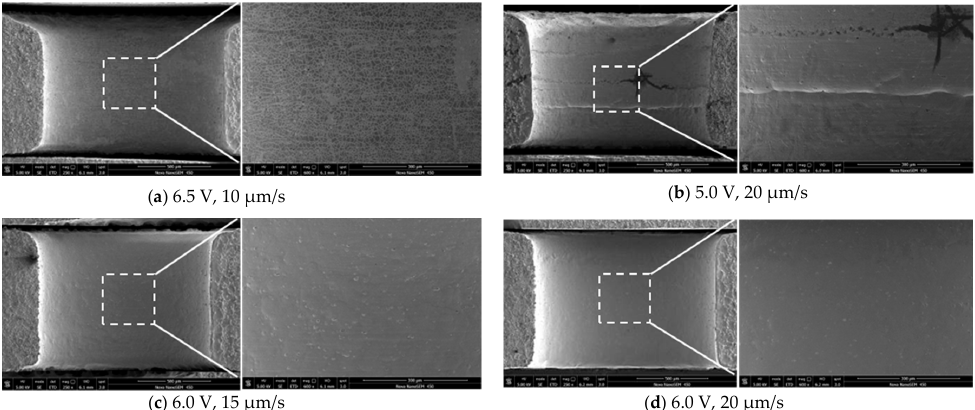
Figure 13. Section view of small holes with different applied voltage and feed rate.